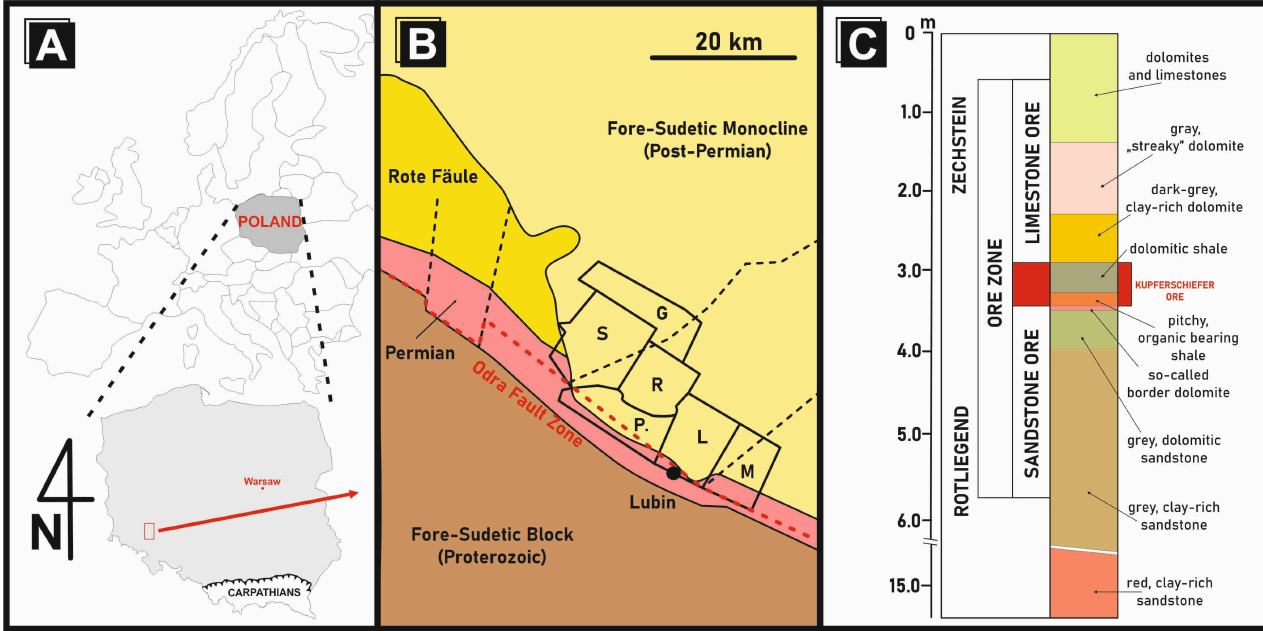
Figure 1. ( A ) Simplified map of Poland with ( B ) the Lubin–Sieroszowice Cu-Ag deposits, including the following main mining fields: G—Głog ó w Deep; S—Sieroszowice; R—Rudna; P—Polkowice; L—Lubin; M—Małomica. Modified after the literature [2], and ( C ) schematic lithological profile with the Kupferschiefer ore position (based on